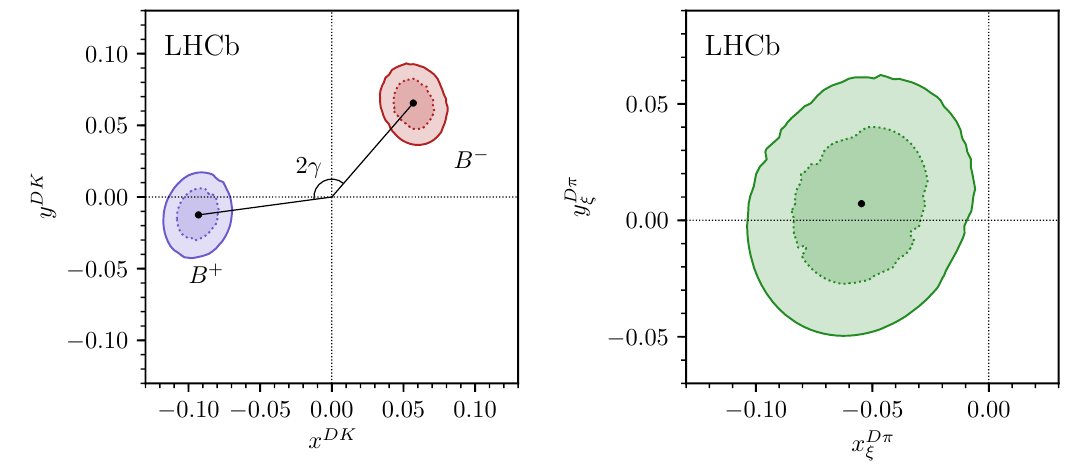
Figure 5 . Confidence levels at 68.2 % and 95.5 % probability for (left, blue) ( x DK ± red) ( x DK ± , y DK ± ) , and (right, green) ( x Dπ ± − − decays with a profile likelihood scan. The black dots show the central values